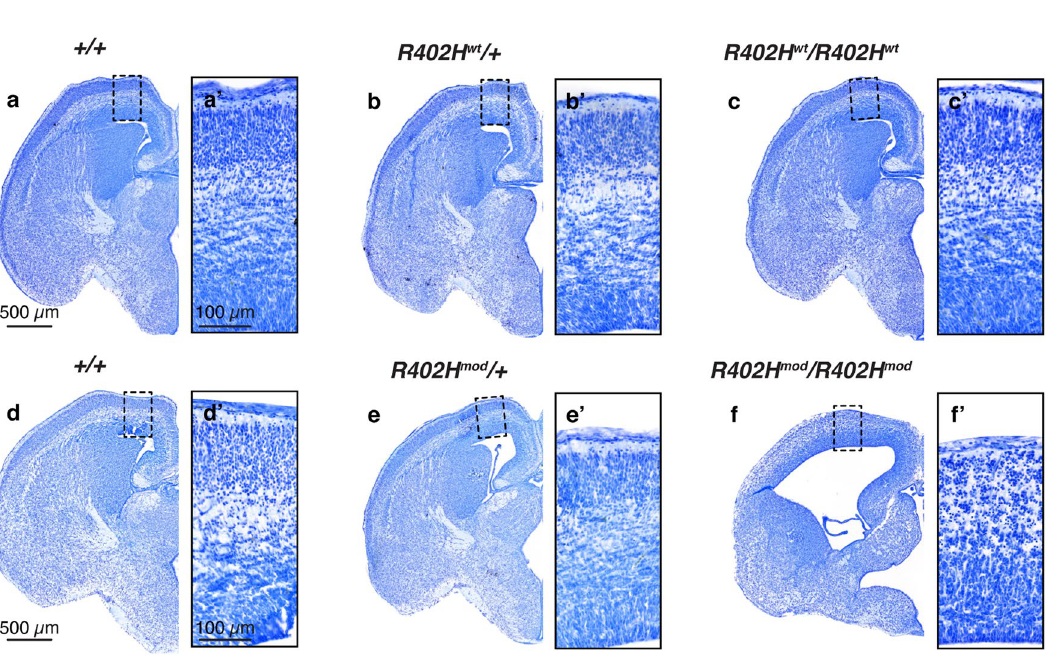
Figure 2. R402H mod /R402H mod embryos show a severe neurodevelopmental phenotype which is not observed in R402H wt /R402H wt mice. ( a–c ) Representative coronal sections of E16.5 embryos stained with Nissl. Wild-type (+/+), heterozygous ( R402H wt / +) and homozygous ( R402H wt /R402H wt ) animals are indistinguishable. ( a ′ –c ′ ) Enlargements of the boxed areas marked in ( a–c ) showing no differences in cortical organization between genotypes. ( d–f ) Representative coronal sections of E16.5 embryos stained with Nissl of wild-type (+/+), heterozygous ( R402H mod / +) and homozygous ( R402H mod /R402H mod ) animals. Brain development is significantly impaired in homozygotes, leading to perinatal lethality. ( d ′ –f ′ ) Enlargements of the boxed areas marked in ( d–f ) showing a severe cortical disorganization in R402H mod /R402H mod embryos compared to littermates. Scale bars indicate 500 μm in ( a ) and ( d ), and 100 μm in ( a ′ ) and ( d ′